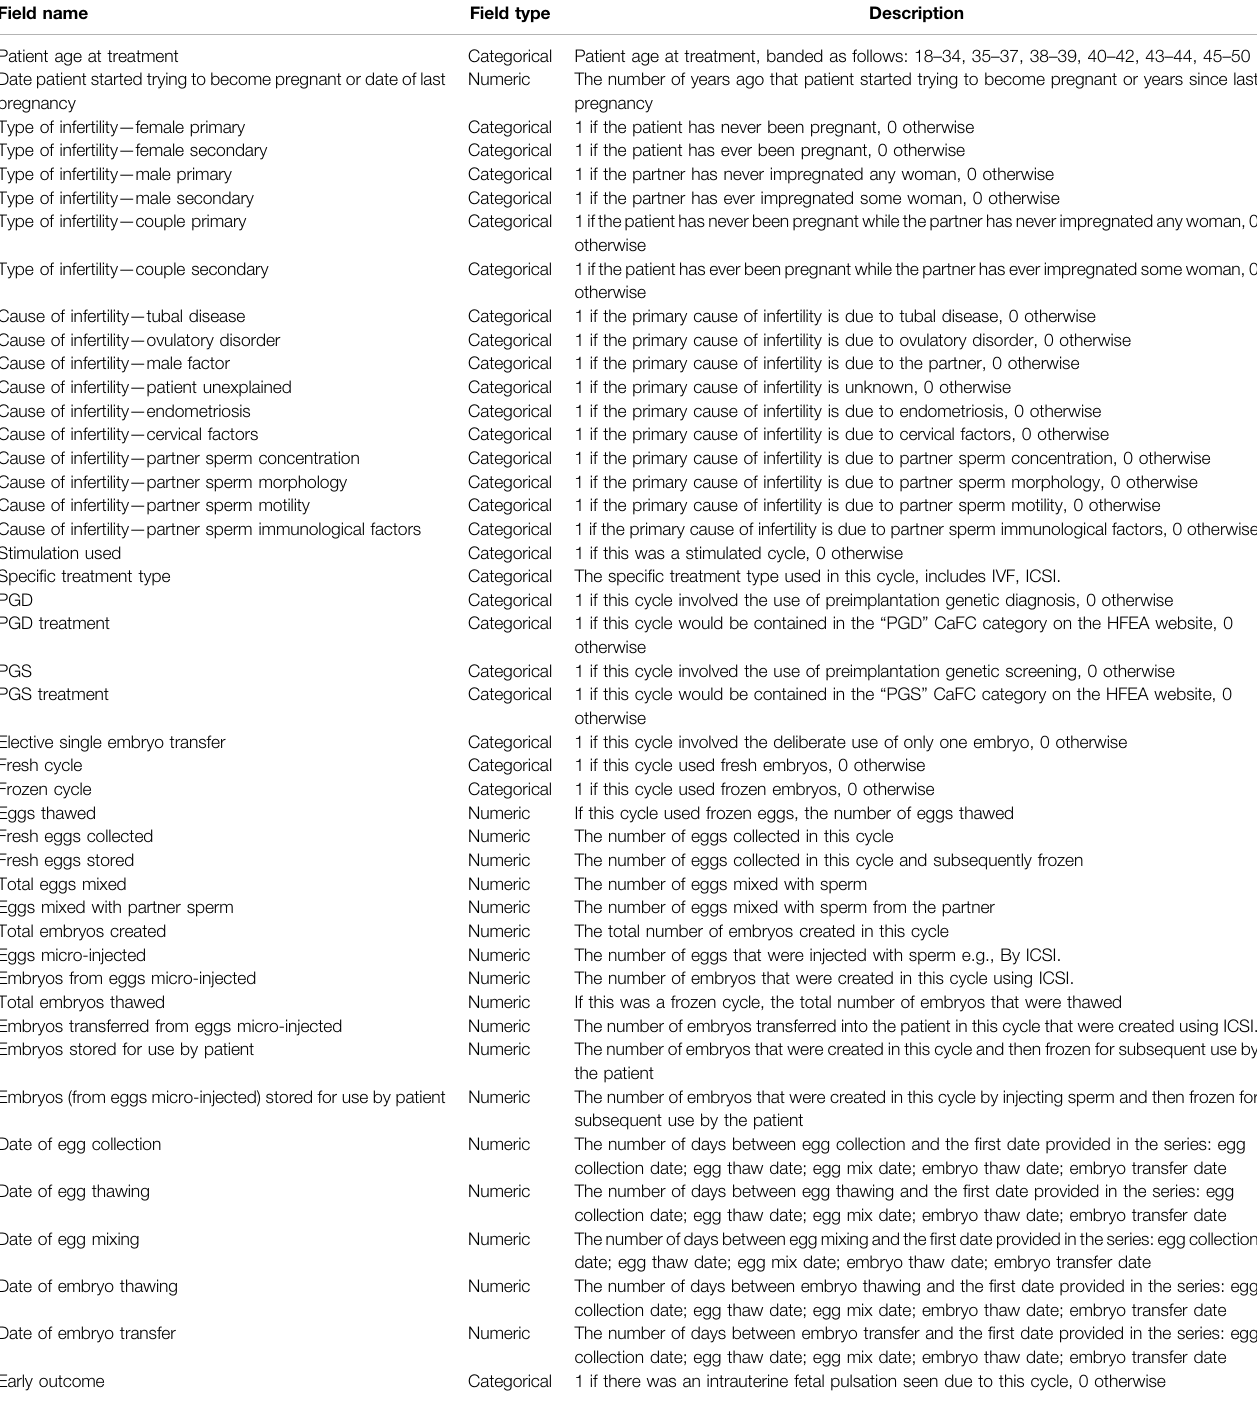
TABLE 1 | Description of 45 fi elds in the data